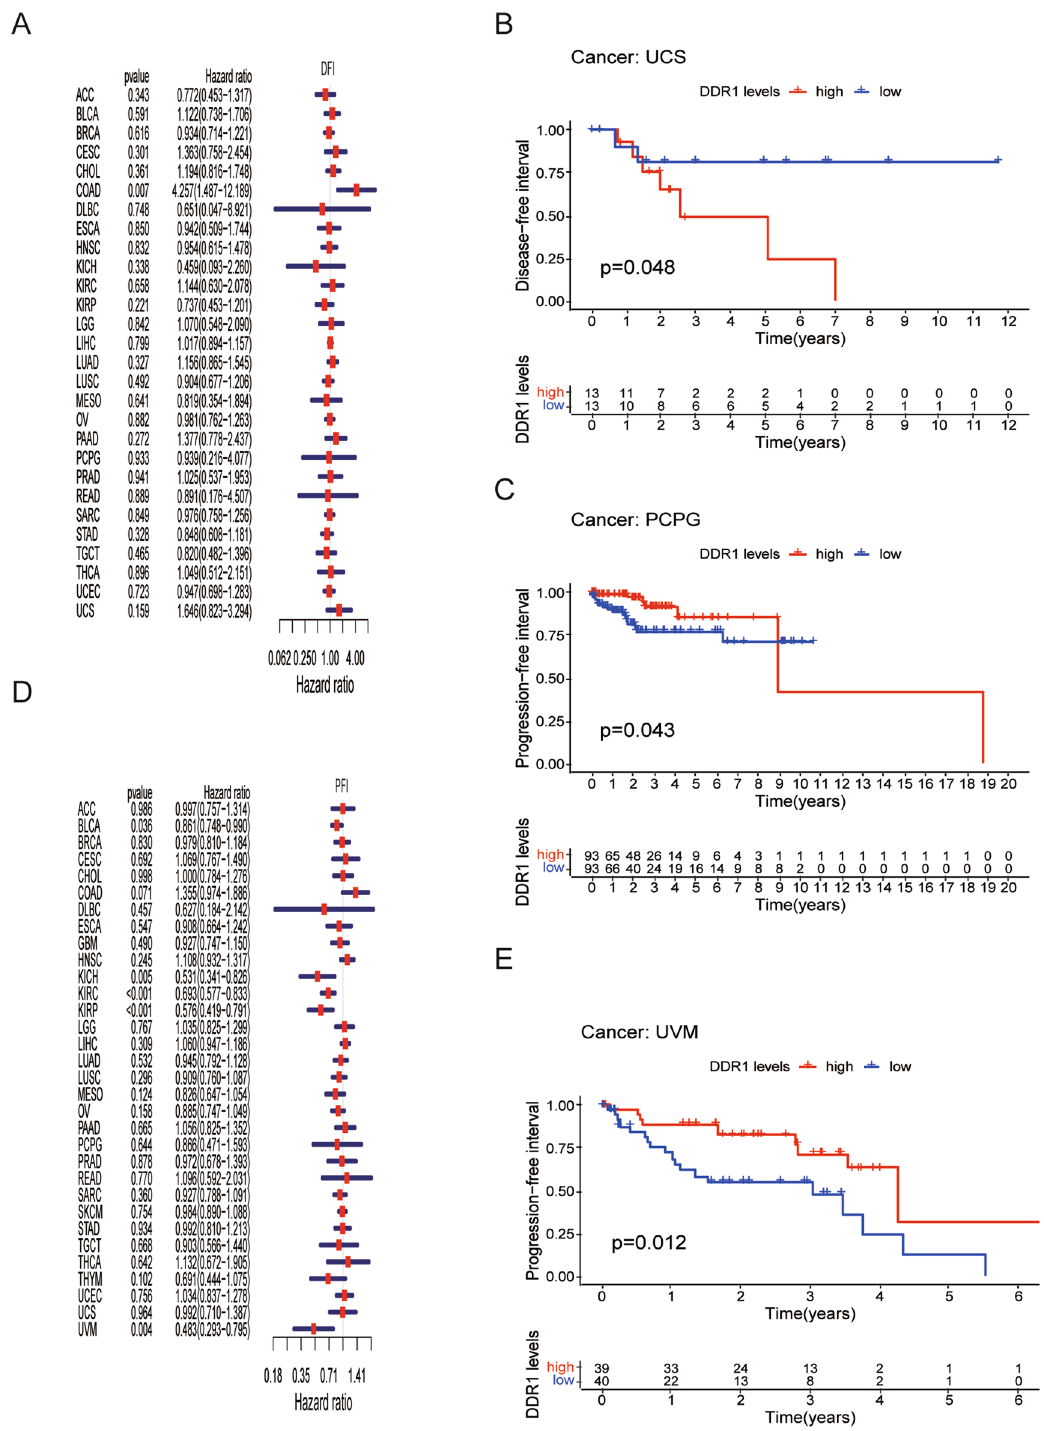
Figure 5. Association between DDR1 expression and disease-free interval (DFI) and progression-free interval (PFI). ( A, D ) Forest plot shows the univariate Cox regression results for the association between DDR1 expression and DFI and PFI in 33 types of tumors, respectively. ( B ) Kaplan–Meier analysis of the association between DDR1 expression and DFI. ( C, E ) Kaplan–Meier analysis of the association between DDR1 expression and